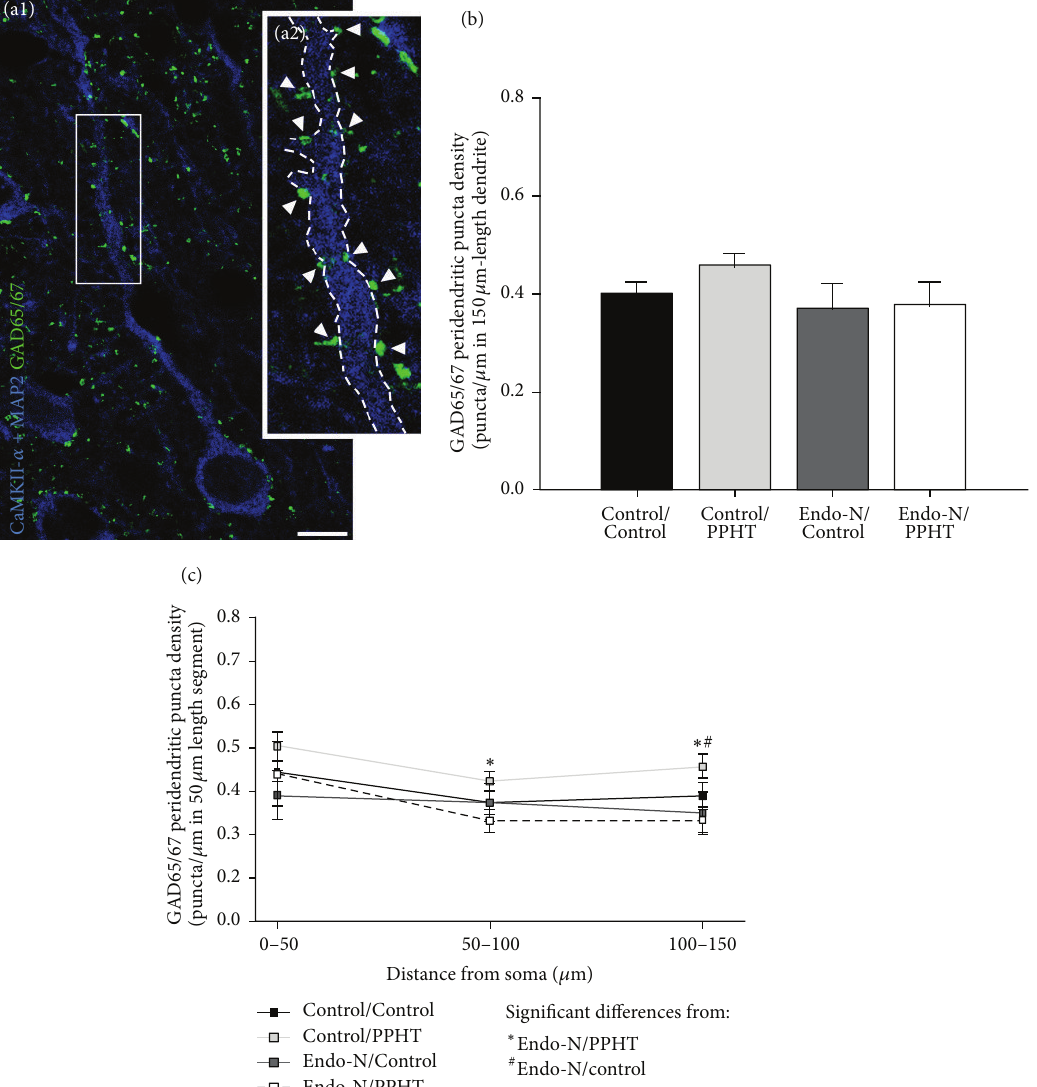
Figure 5: Confocal microscopic analysis of GAD65/67 expressing puncta in the peridendritic region of mPFC pyramidal neurons after Endo-N or PPHT treatments and their combination. (a1-a2) Single confocal planes showing a pyramidal neuron somata and its apical dendrite (immunolabeled for CaMKII- 𝛼 and MAP2; blue color and marked with dashed line) innervated by GABAergic puncta (GAD65/67 immunoreactive puncta; green color and marked with arrowheads). (a2) is a 3x magnification of the squared section in (a1). Scale bar for (a1): 10 𝜇 m. (b) Graph showing no changes in the peridendritic density of GAD65/67 expressing puncta (puncta/ 𝜇 m) when considering the total length (200 𝜇 m) of the measured dendrites. (c) Graph representing GAD65/67 peridendritic puncta density as a function of distance from the soma in 50 𝜇 m length segments. In both graphs, 6 animals per group were analyzed. Error bars represent SEM and symbols in bars indicate statistically significant differences between groups after one-way ANOVA followed by Bonferroni’s correction (see graph legend).